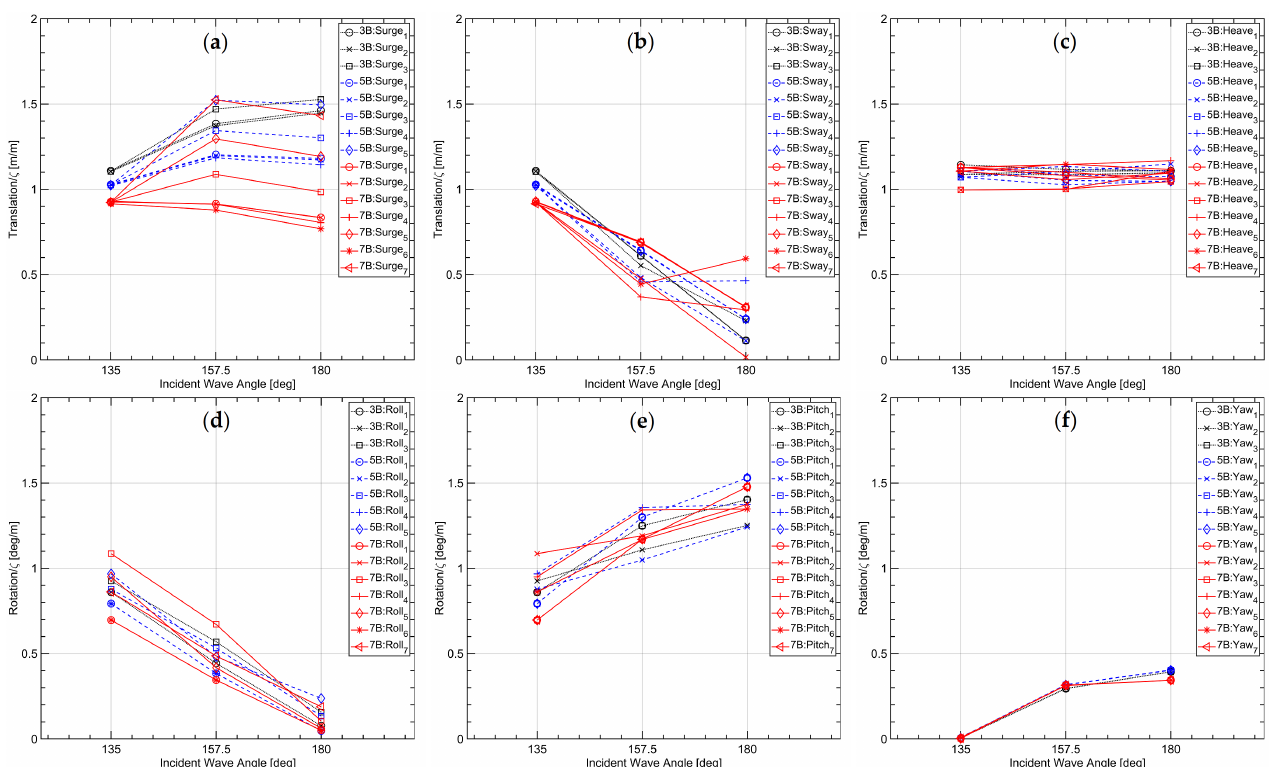
Figure 21. Normalized motion response amplitudes in six degrees of freedom vs. incident wave angle in regular waves of frequency 0.415 rad/s, where n B denotes the configuration with n bodies; subscript n , the corresponding n -th body’s motion response: ( a ) surge; ( b ) sway; ( c ) heave; ( d ) roll; ( e ) pitch; ( f )